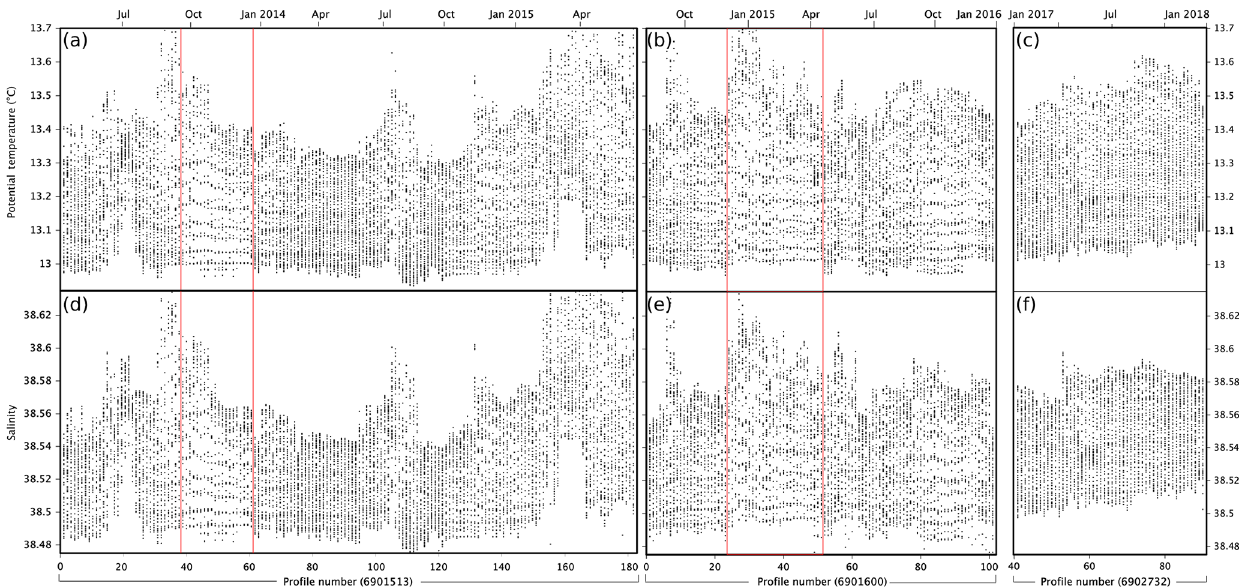
Figure 8. Temperature (a–c) and salinity (d–f) recorded between 300 and 1000dbar with a vertical resolution of 10dbar, by the three floats 6901513 (a, d) , 6901600 (b, e) and 6902732 (c, f) deployed in the Algerian Basin. Values on the x axis correspond to the number of the successive profiles with a temporal resolution of 1 to 7d. The timeframe (in trimesters) is superimposed on top of the x axis. The two episodes described in the text (Sect. 3.2) are delimited by red vertical